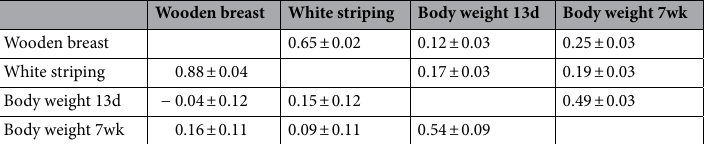
Wooden breast White striping Body weight 13d Body weight 7wk Wooden